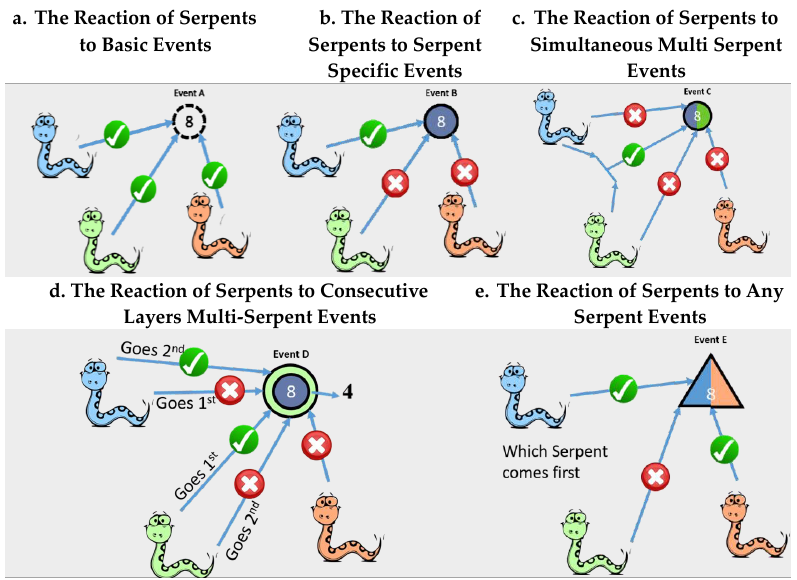
Figure 3. Serpent reactions under various situations.